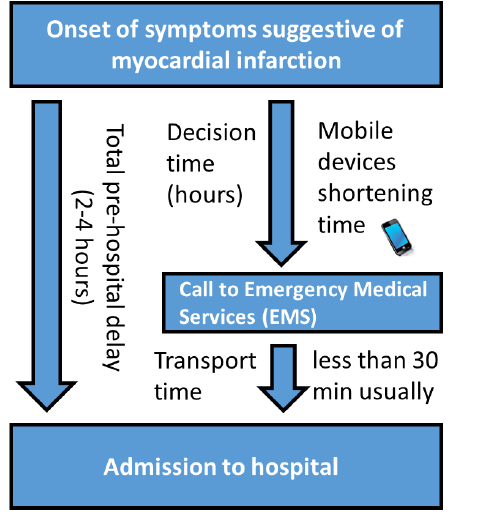
Figure 1. Total pre-hospital